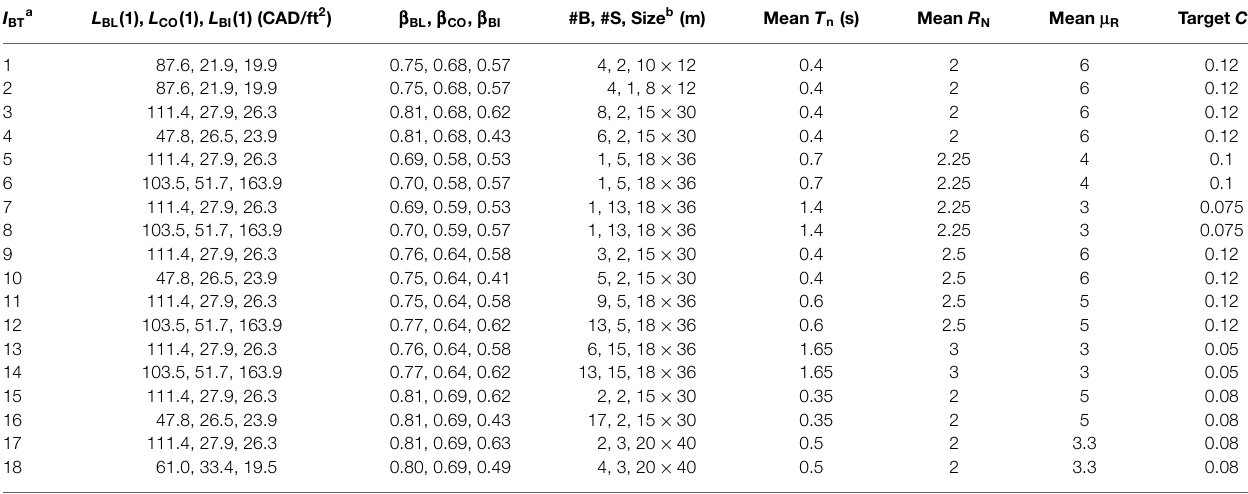
TABLE 2 | Damage cost information (Goda and Hong, 2008b) and considered portfolio of buildings for downtown Vancouver. I